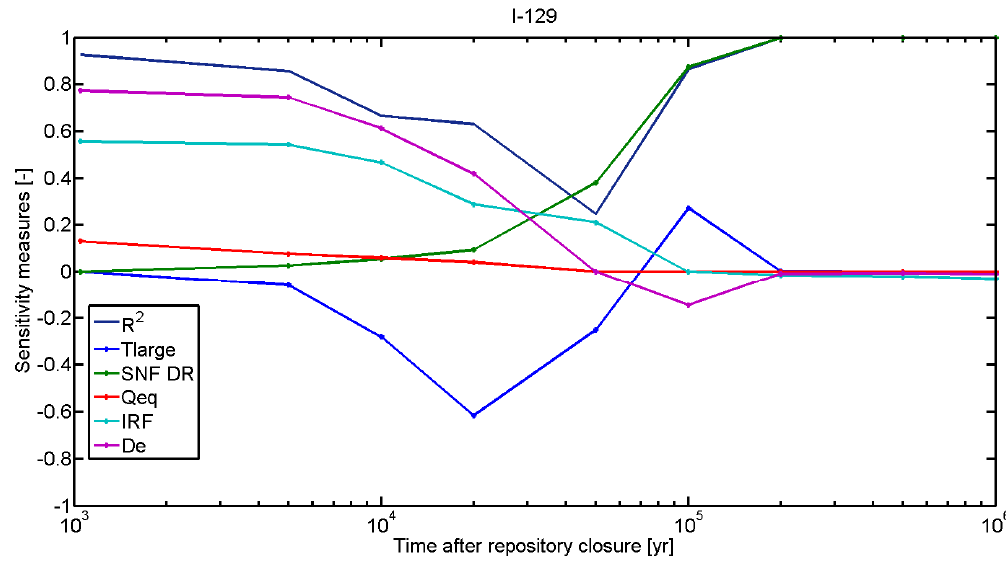
Figure 3. Standardized rank regression coe ffi cients (SRRC) as parameter importance measures and the coe ffi cient of determination R 2 over the analyzed period for I-129 flux as presented in [21] (R 2 —coe ffi cient of determination, Tlarge—defect size enlargement time, SNF DR—SNF (spent nuclear fuel) matrix dissolution rate, Qeq—equivalent groundwater flow rate around the canister, IRF—instant release fraction, De—e ff ective di ff usivity of I-129 in